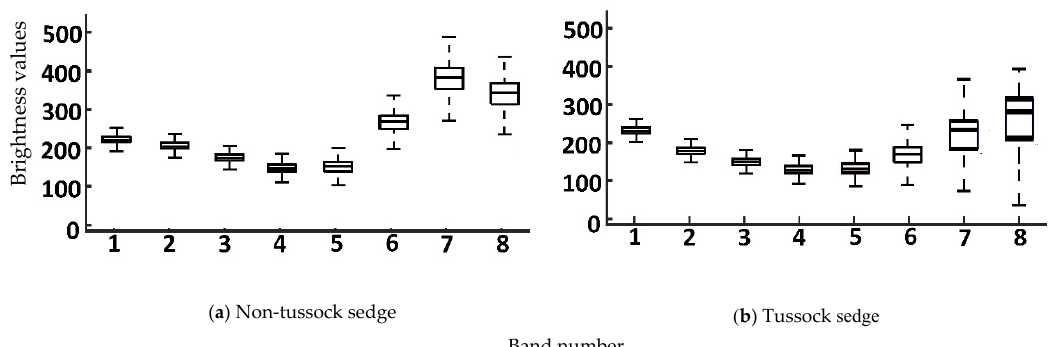
Figure 5. Box plot for the multispectral band datasets. In each box, the central mark is the median, and the edges are the first and third quartiles.